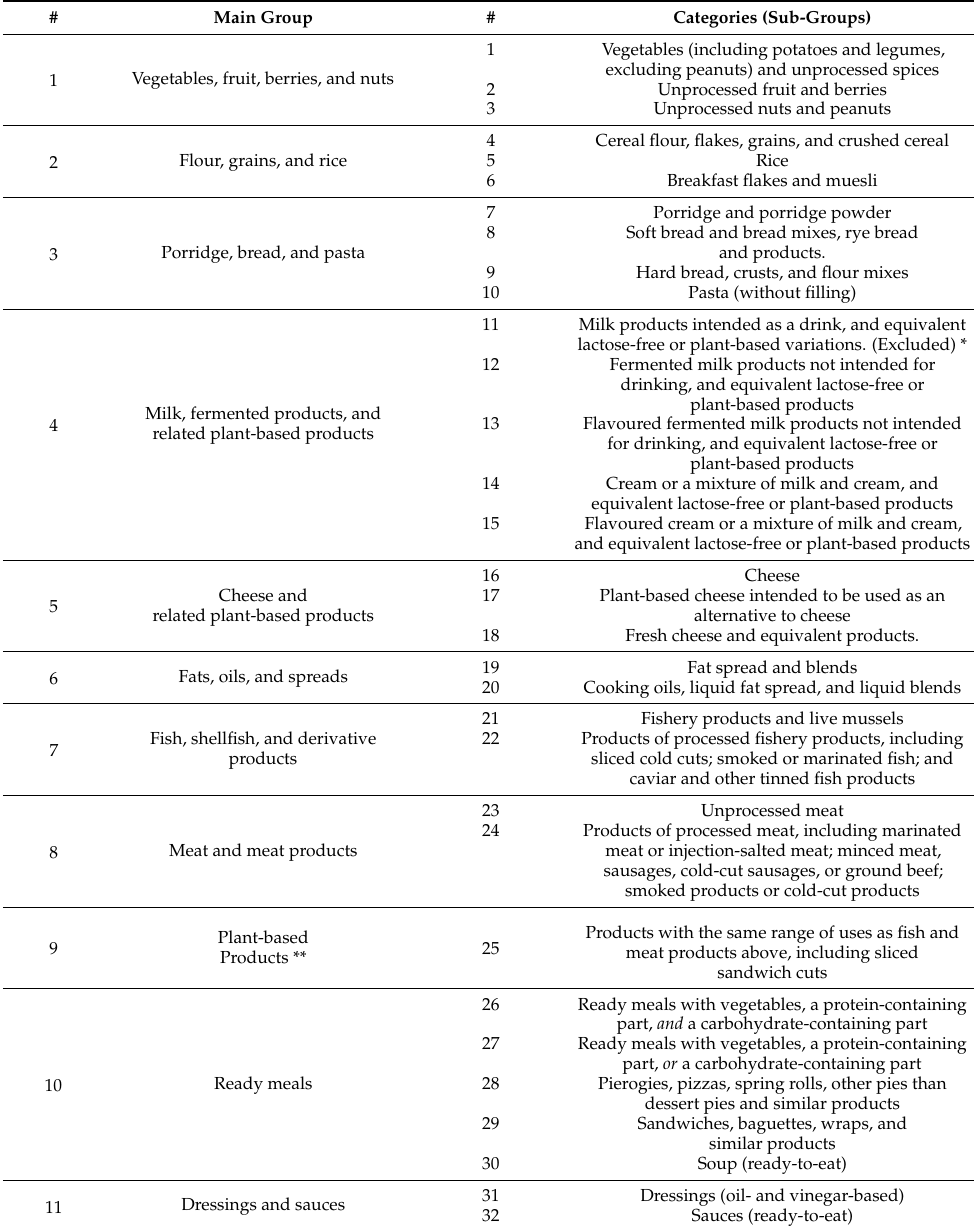
Table A1. Main food groups and categories (i.e., sub-groups) included in the current Keyhole eligibility criteria (LIVSFS